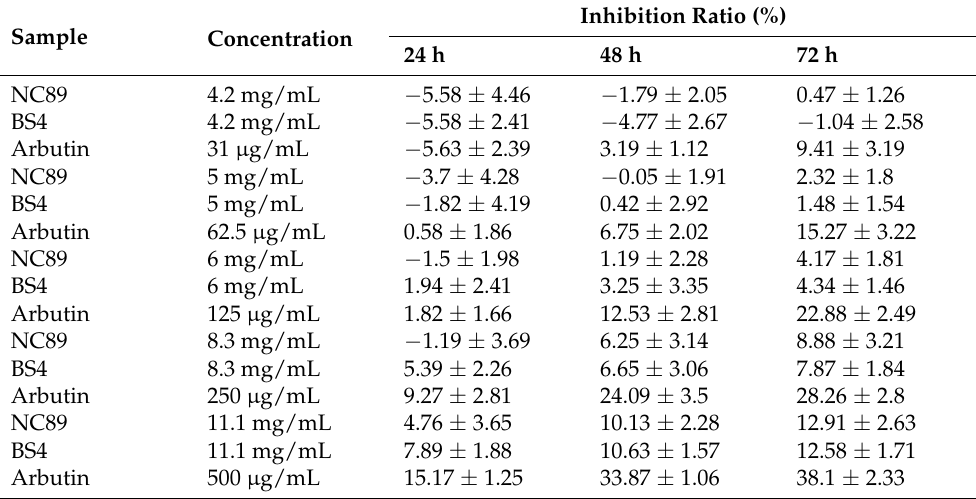
Table 5. Inhibitory effect of tobacco seed oil on tyrosinase in B16